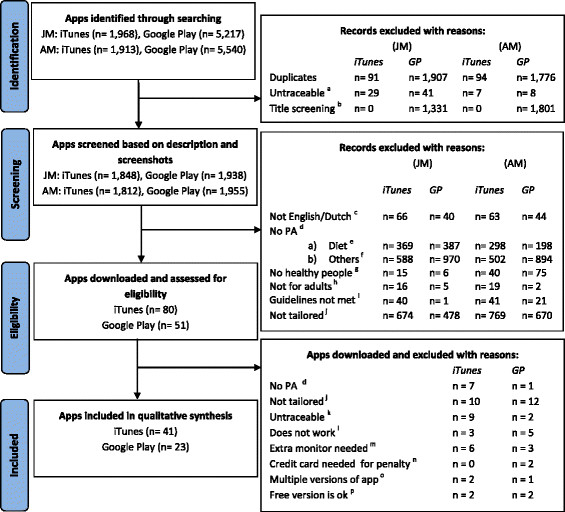
Flow chart: schematic overview of the selection process for apps eligible for full review. This flow chart provides a schematic overview of the selection process of eligible apps available in iTunes and Google Play (GP). The initials of the main reviewers are reported as JM and AM. aApps on the list of one researcher were untraceable for the other researcher. bApps to which the adjusted screening method had been applied and only the titles were screened. cApps that were not available in English or Dutch. dThe main focus of the apps was not physical activity (PA) promotion. eApps that focused on diet and weight loss. fThe main focus of the apps was not physical activity (PA) promotion or weight loss. gApps that targeted people with injuries or disabilities. hApps that targeted children or older adults. iApps did not follow the guidelines for physical activity. jApps that did not provide tailored feedback. kApps that were detected in the first screening step and were not available for download. lAfter downloading the app, it did not work. mAn extra monitor or device was needed to receive tailored feedback. nBefore using the app, a credit card was needed to deduct money as a penalty if the user did not achieve self-defined goals. oThe same app was available under a different name but with the same features. pThe app had a free and a paid version, but the paid version did not have additional features.